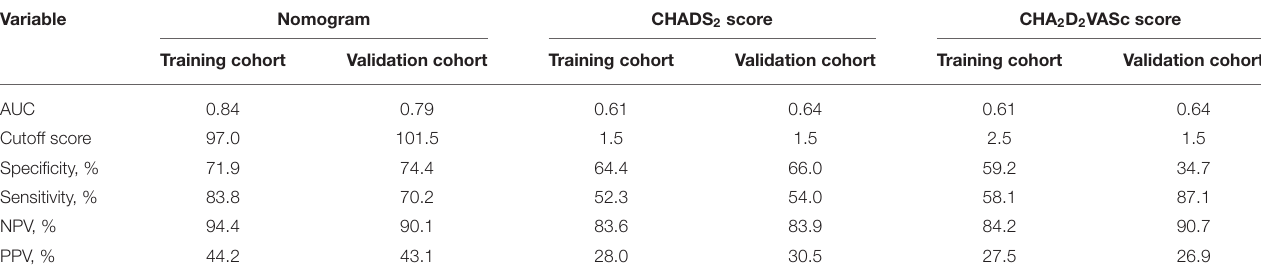
TABLE 3 | Accuracy of the prediction score of the nomogram for estimating the risk of LAT/SEC.